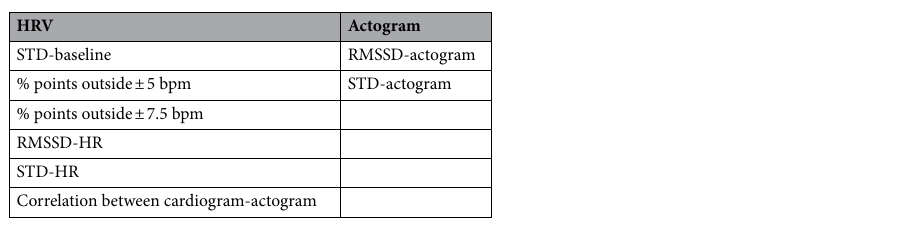
Table 4. Summary of the parameters used in the current